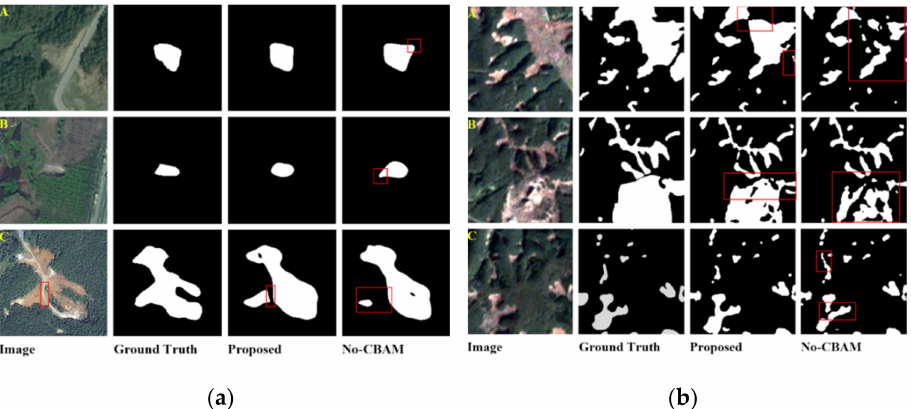
Figure 10. The resulting comparison of two models with and without CBAM in the Bijie dataset ( a ) and the Iburi dataset ( b ). Black color represents the background, white color represents the landslide area. Red polygons show the areas that were not fully identified by the models. A–C are images randomly selected from the testing samples for visual